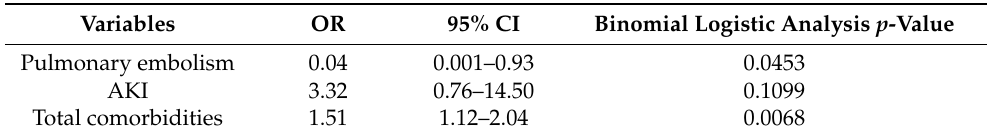
Table 3. Stepwise logistic multivariate analysis obtained the main differential factors among patients belonging to Delta and Omicron groups on ICU COVID-19